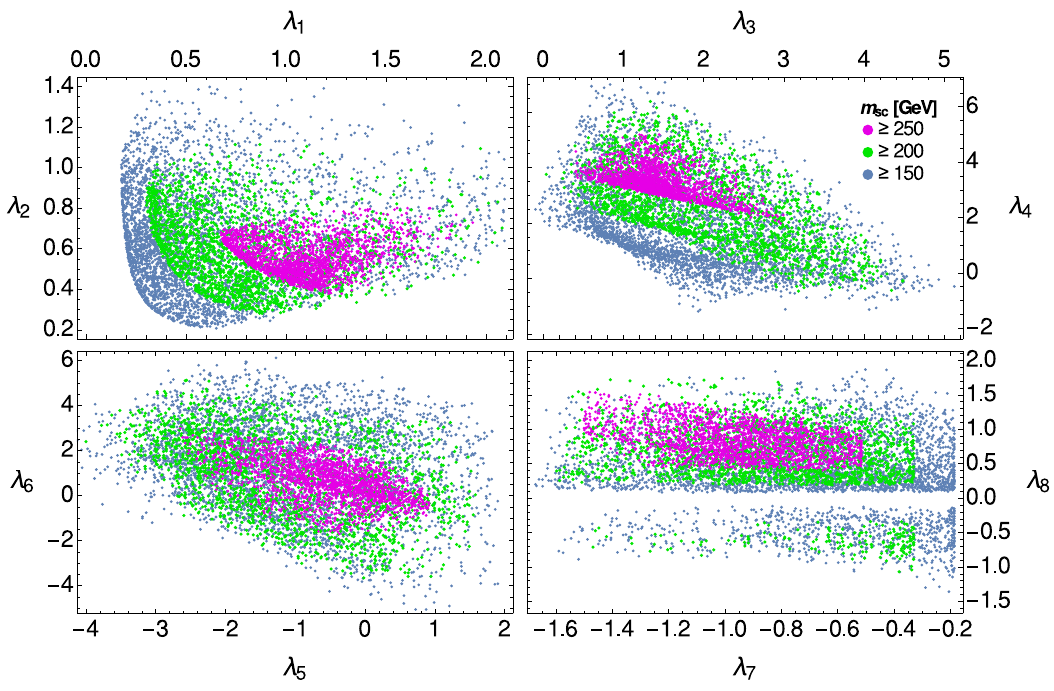
Figure 7 . Scatter plots of the λ p . The notation for the colours of the points is the same as in figure